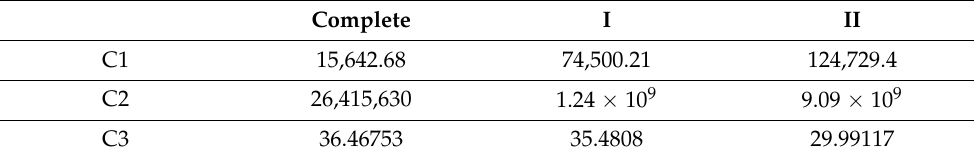
Table 11. Optimality